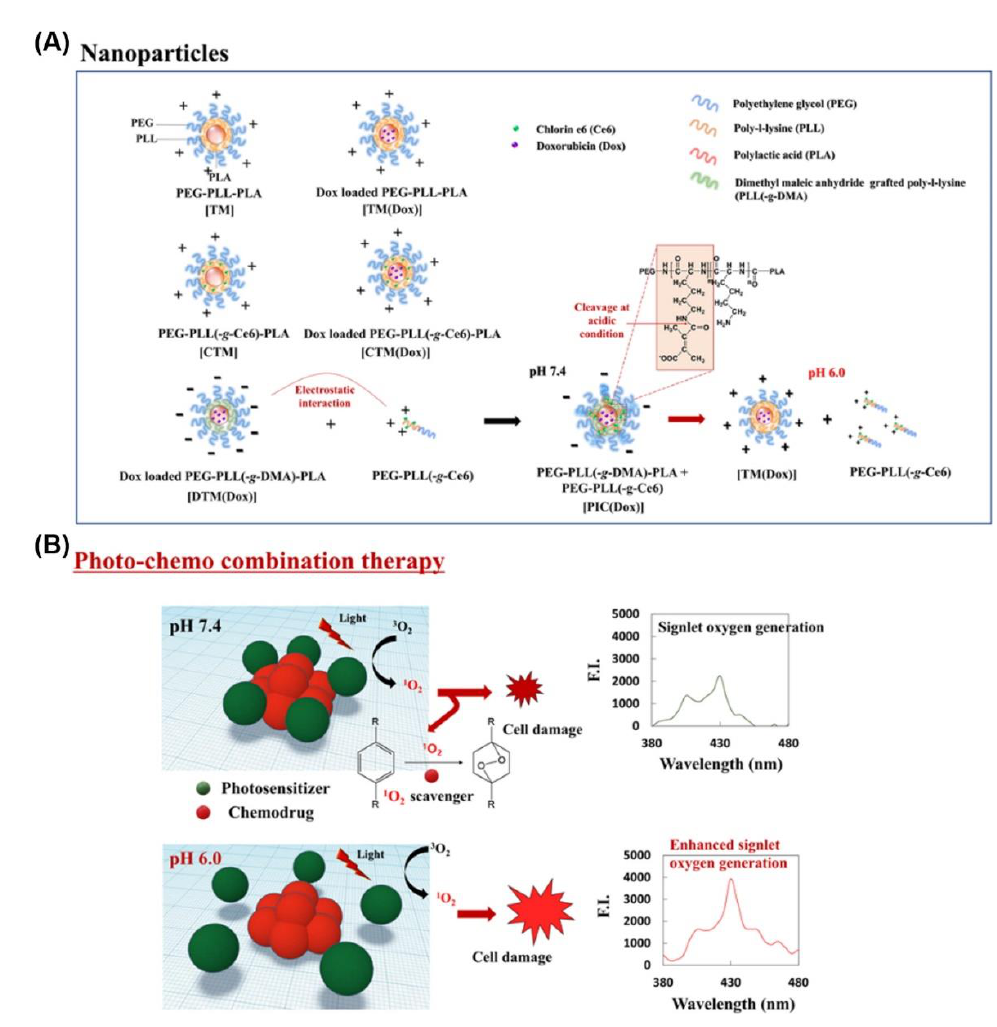
Figure 12. ( A ) Prepared drug loading nanoparticles. ( B ) Photosensitizer and chemo-drug interaction in the process of generating singlet oxygens. Reproduced from [171] with permission, copyright 2019, Elsevier.